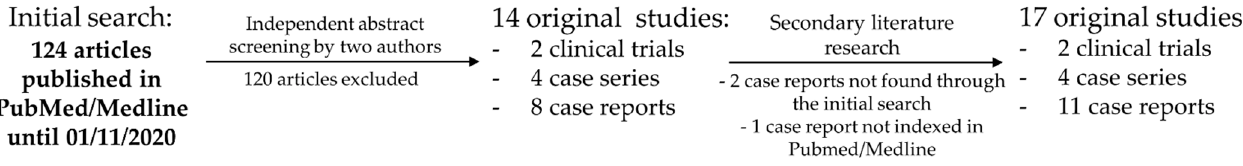
Figure 2. Literature research workflow.